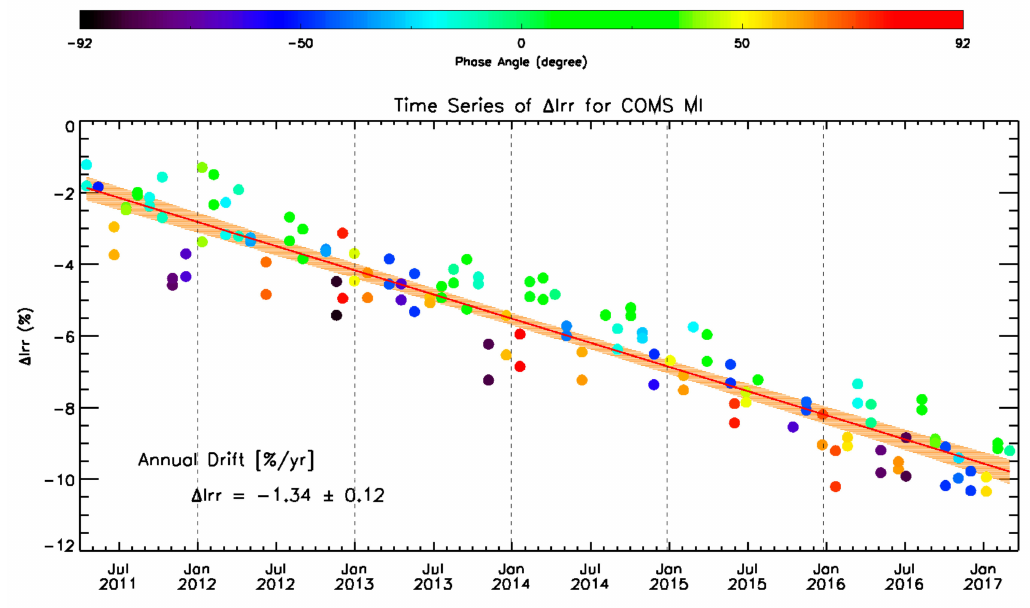
Figure 2. Temporal trend of COMS MI visible channel calibration from April 2011 to March 2017. Colors represent Moon phase angles and orange shades represent the 95% confidence interval of the linear